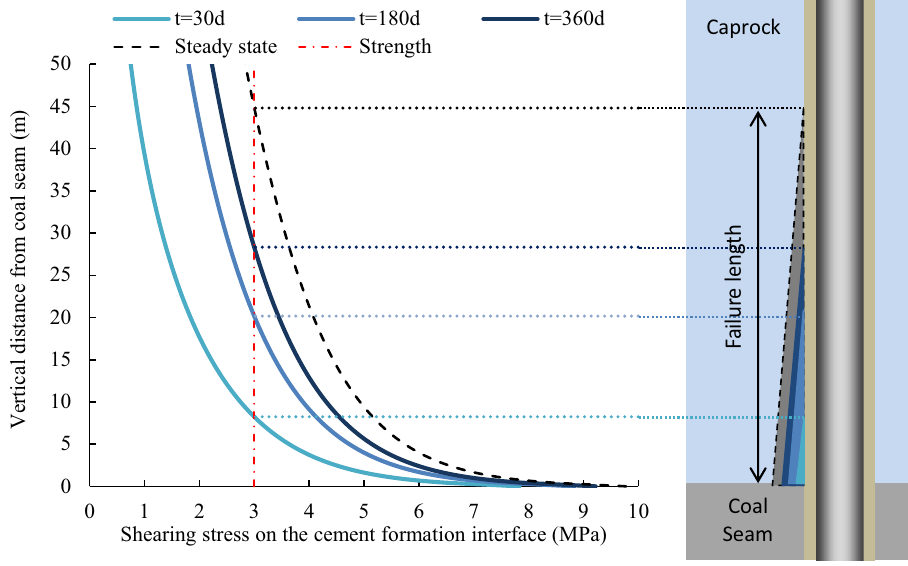
Fig. 3 Shearing stress on the cement-formation interface under various CO 2 injecting times by assuming the cement- formation interface strength is 3